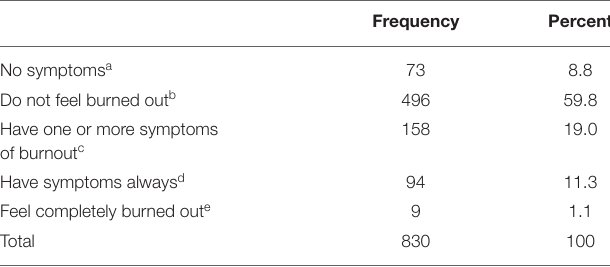
TABLE 2 | Distribution of the participants’ emotional exhaustion